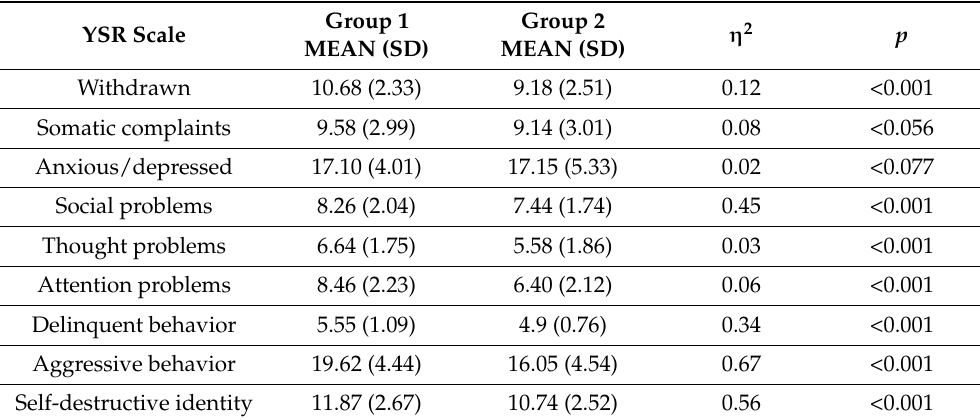
Table 1. Mean scores, standard deviations for Groups 1 and 2 on the YSR scales.